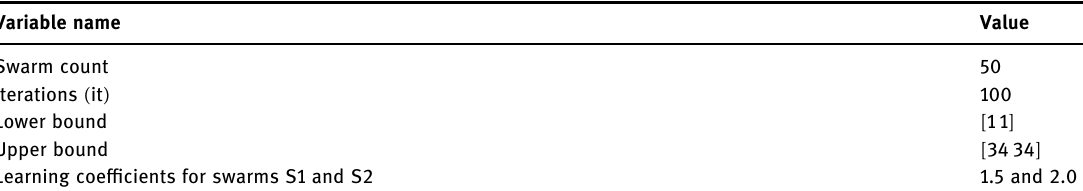
Table 2: PSO Initialization parameters